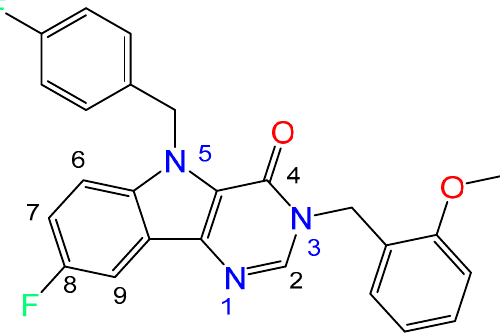
Figure 1. Chemical structure of title compound ( 3 ) .